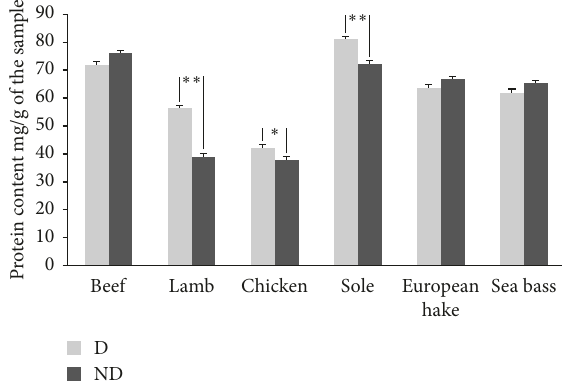
Figure 2: Protein solubility of myofibrillar proteins from the muscle of beef, lamb, chicken, sole, European hake, and sea bass using denaturing and nondenaturing solution (D � denaturing; ND � nondenaturing; ∗ P < 0 . 05; ∗∗ P < 0 . 01) (means ± SEM).